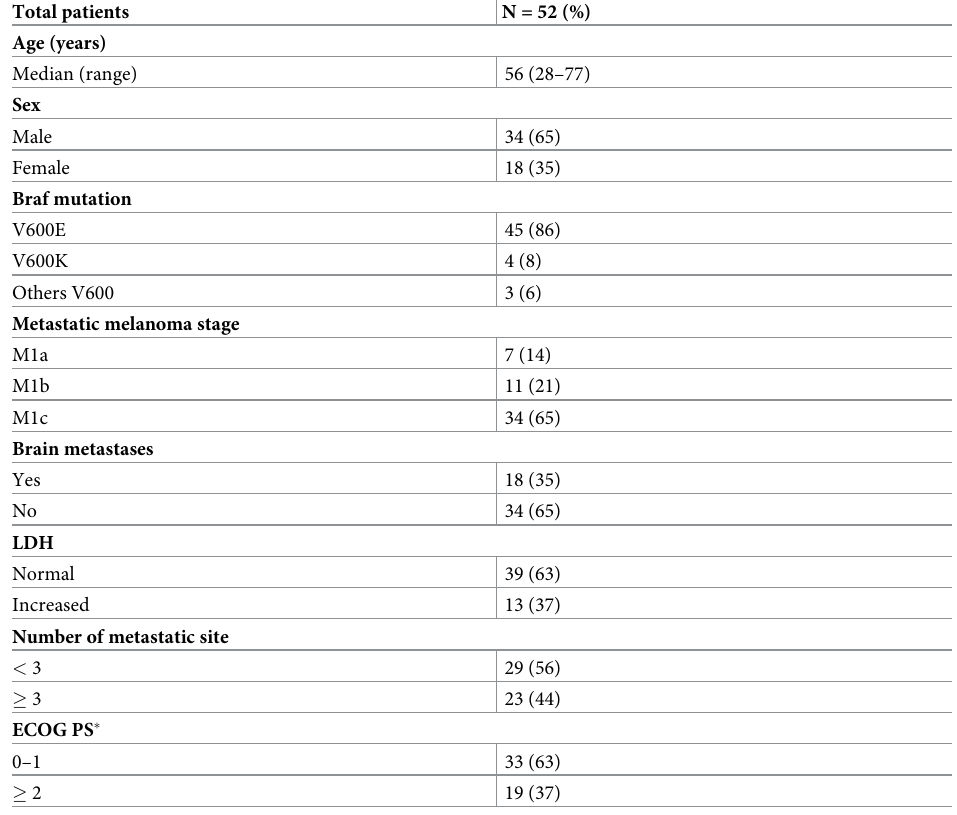
� ECOG PS = Eastern Cooperative Oncology Group Performance